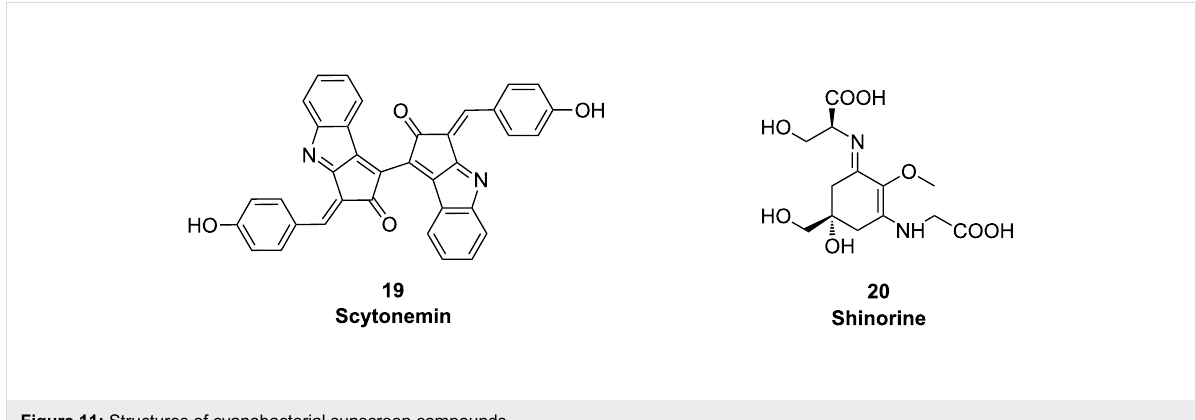
Figure 11: Structures of cyanobacterial sunscreen compounds.